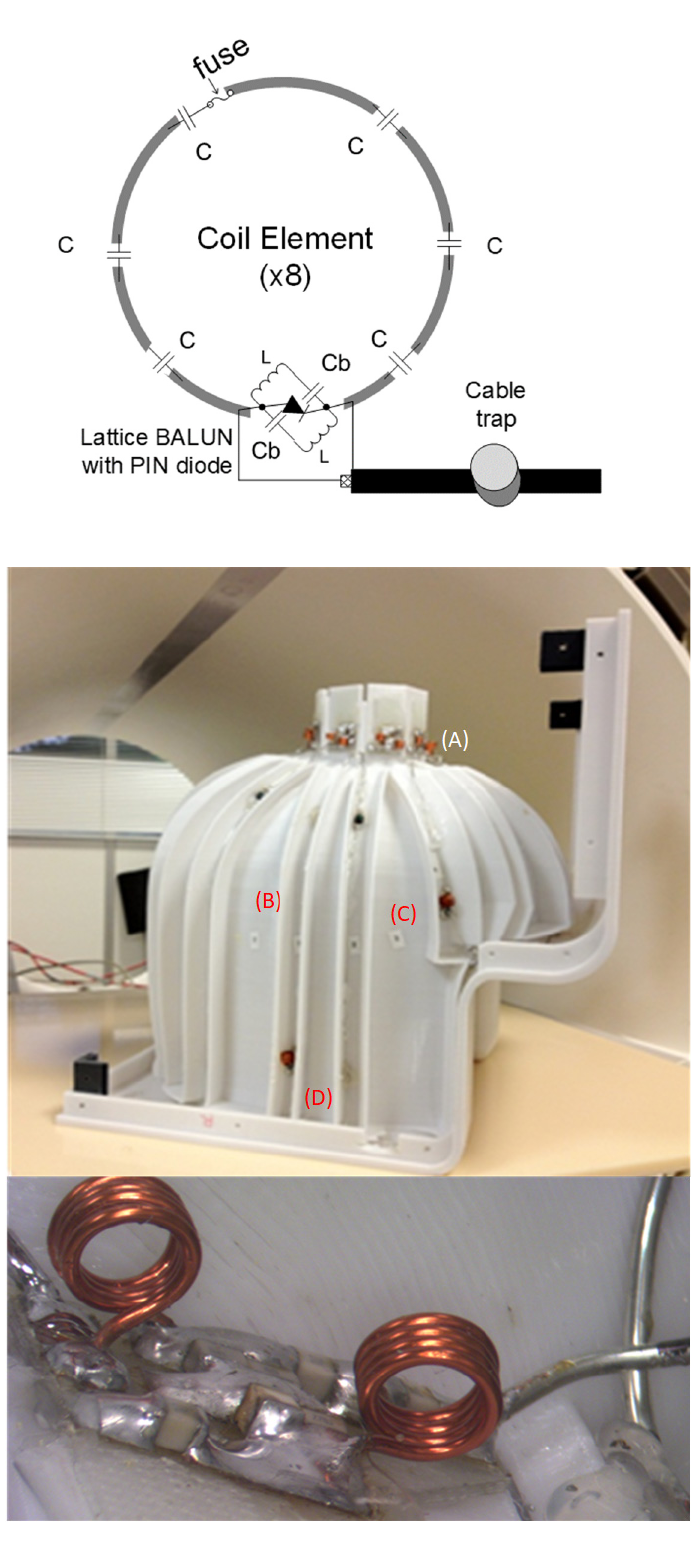
Figure 2. ( Top ) Schematics of the RF coil and the active decoupling. ( Middle ) The 3D-printed eight- channel phased-array helmet: (A) lattice balun with a PIN diode for detuning during transmission, (B) copper wires loops, (C) distributed capacitors, and (D) fuses. ( Bottom ) A detailed image of the lattice balun and every soldering was inspected and